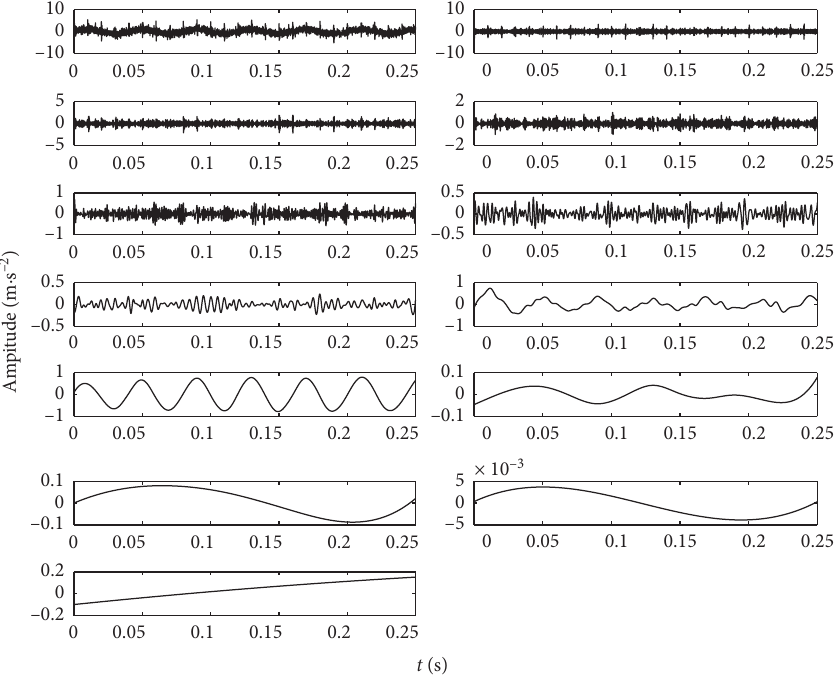
Figure 6: EEMD components. Table 3: Correlation coefficient of EEMD components.